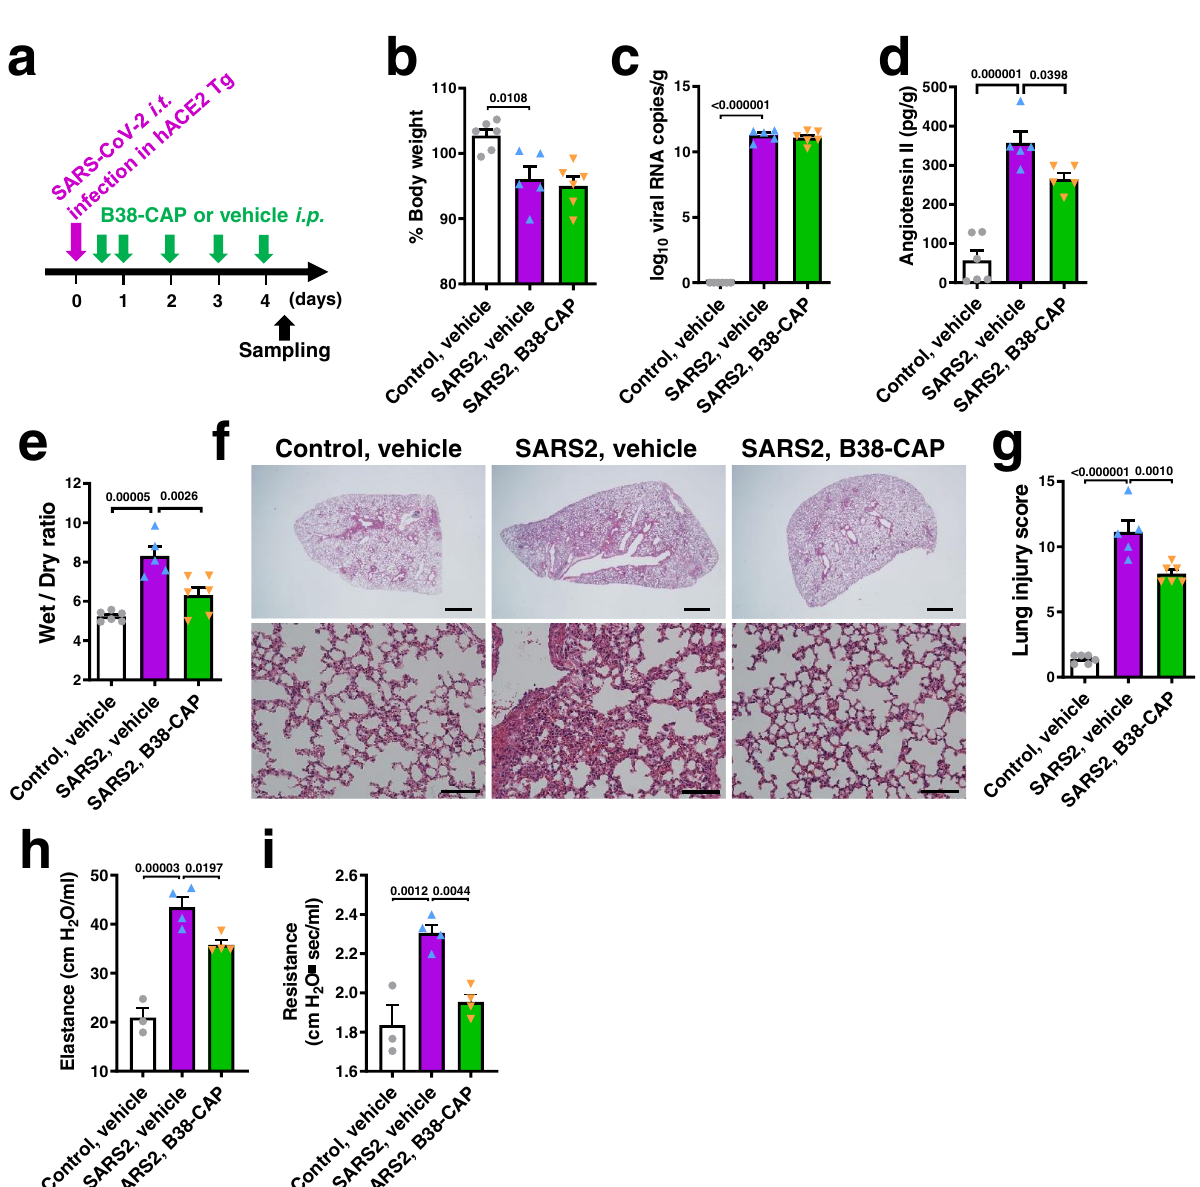
Fig. 6 B38-CAP improves SARS-CoV-2-induced lung injury and respiratory dysfunction in hACE2 Tg mice. a Experimental protocol; hACE2 Tg mice were i.t. infected with SARS-CoV-2 (2 × 10 3 TCID 50 ), and then the mice were injected with B38-CAP (2 mg/kg i.p.) or vehicle once a day. b % Changes of body weight at 4 days after infection from before infection. Uninfected hACE2 Tg mice (control) treated with vehicle ( n = 6), SARS-CoV-2 infected hACE2 Tg mice (SARS2) treated with vehicle ( n = 5), and SARS2 treated with B38-CAP ( n = 6) ( b , c , e , g ). c qRT-PCR of virus N gene expression in the lungs of hACE2 Tg mice. d Angiotensin II levels in the lung tissues ( n = 6 mice for control + vehicle, n = 5 for SARS2 + vehicle and n = 5 for SARS2 + B38-CAP). e Wet to dry ratio of lung weight. f – g Lung histopathology. Representative images are shown ( f ). Bars indicate 1 mm (upper) and 100 μ m (bottom). Lung injury scores were measured ( g ). h – i Lung function measurements. Elastance ( h ) and resistance ( i ) were measured at 4 days after SARS-CoV-2 infection in hACE2 Tg mice; control with vehicle treatment ( n = 3), SARS2 with vehicle ( n = 4), and SARS2 with B38-CAP ( n = 4). All values are means ± SEM. One- way ANOVA with Sidak ’ s multiple comparisons test ( b – e , g – i ). Numbers above square brackets show P values. Independent experiments were performed two times ( h – i ) or three times ( b – g ), and consistent results were